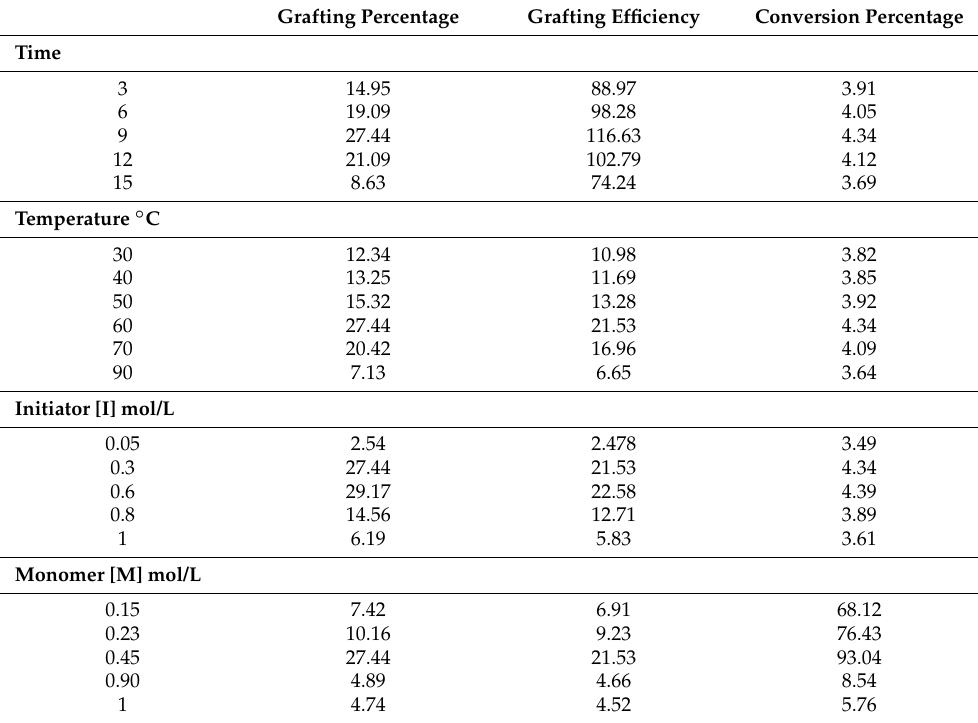
Table 5. The effect of various parameters on the grafting percentage of starch g (MA-DETA) copolymer. (Starch = 2 g, [PPS] = 0.3 mol/L, T = 60 ◦ C and time = 9 h.) Grafting Percentage Grafting Efficiency Conversion Percentage Time 3